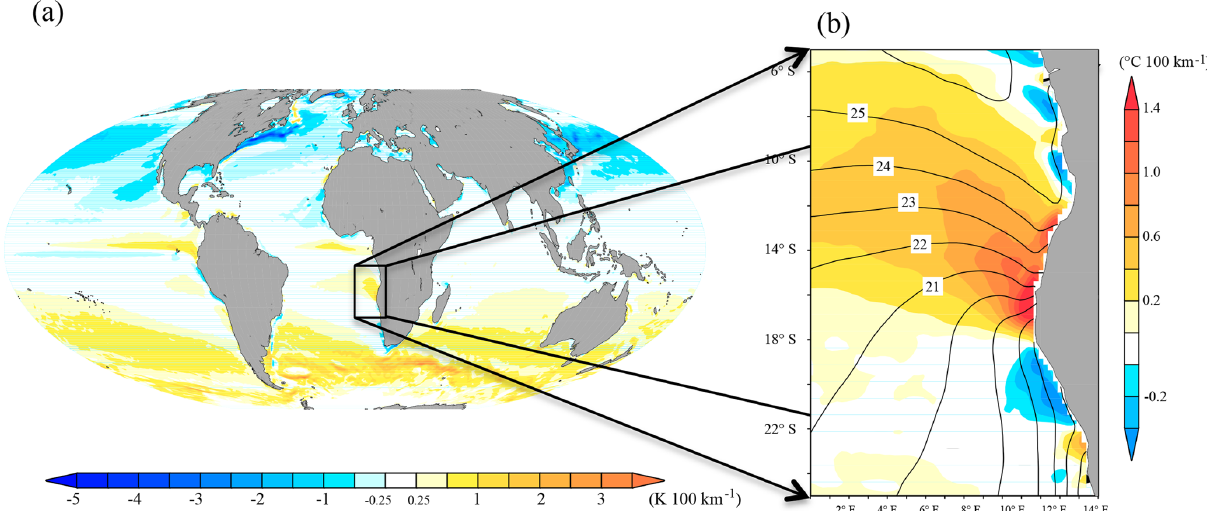
Figure 1. (a) Global image of observed 1982–2010 OISST. (b) Annual-mean SST (contour, ◦ C) and its meridional gradient ( ◦ C per 100km) around the